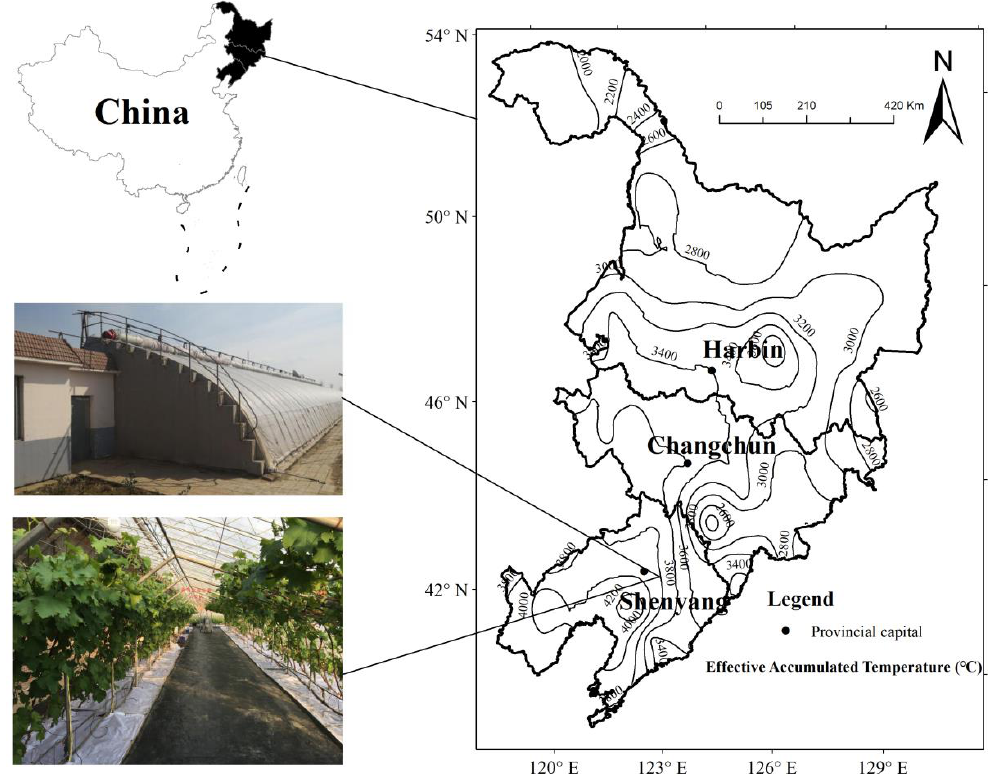
Figure 1. A map of Liaoning Province depicting the location of the site in the study area.